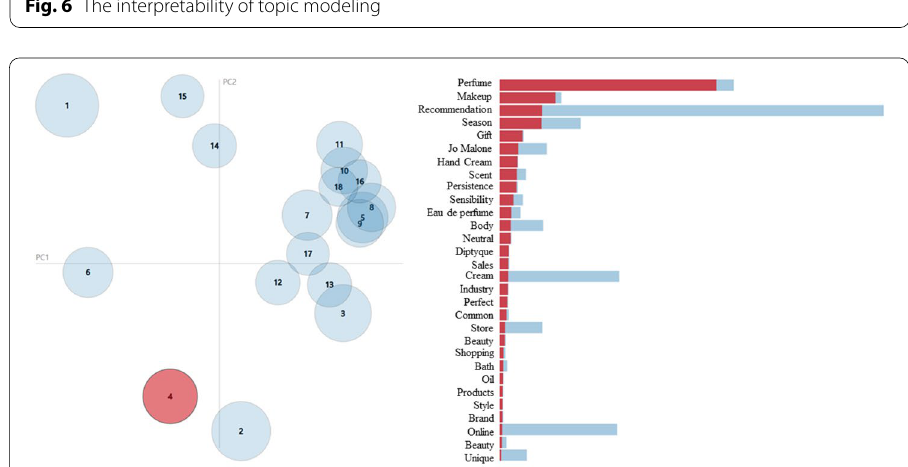
Fig. 6 The interpretability of topic modeling